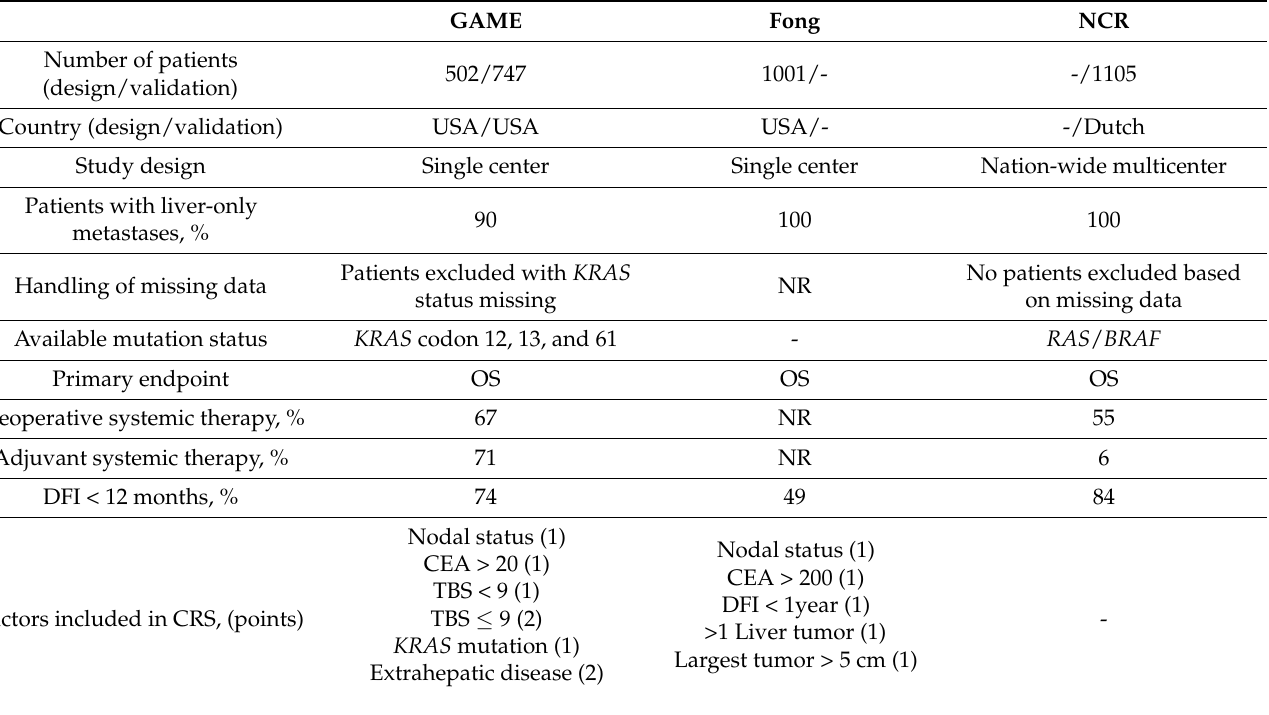
Table 2. Characteristics of original Fong and GAME CRS cohorts compared to Dutch NCR cohort used for external